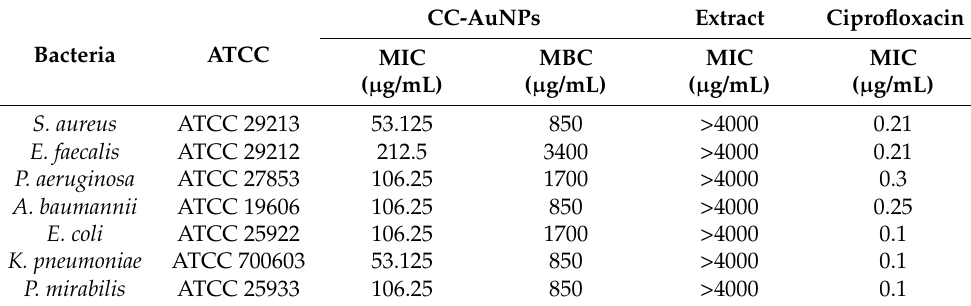
Figure 8. The probable mechanism of the green synthesis of AuNPs using C. caspius extract. Table 2. The MIC and MBC values of CC-AuNPs against several gram-positive and gram-negative bacterial